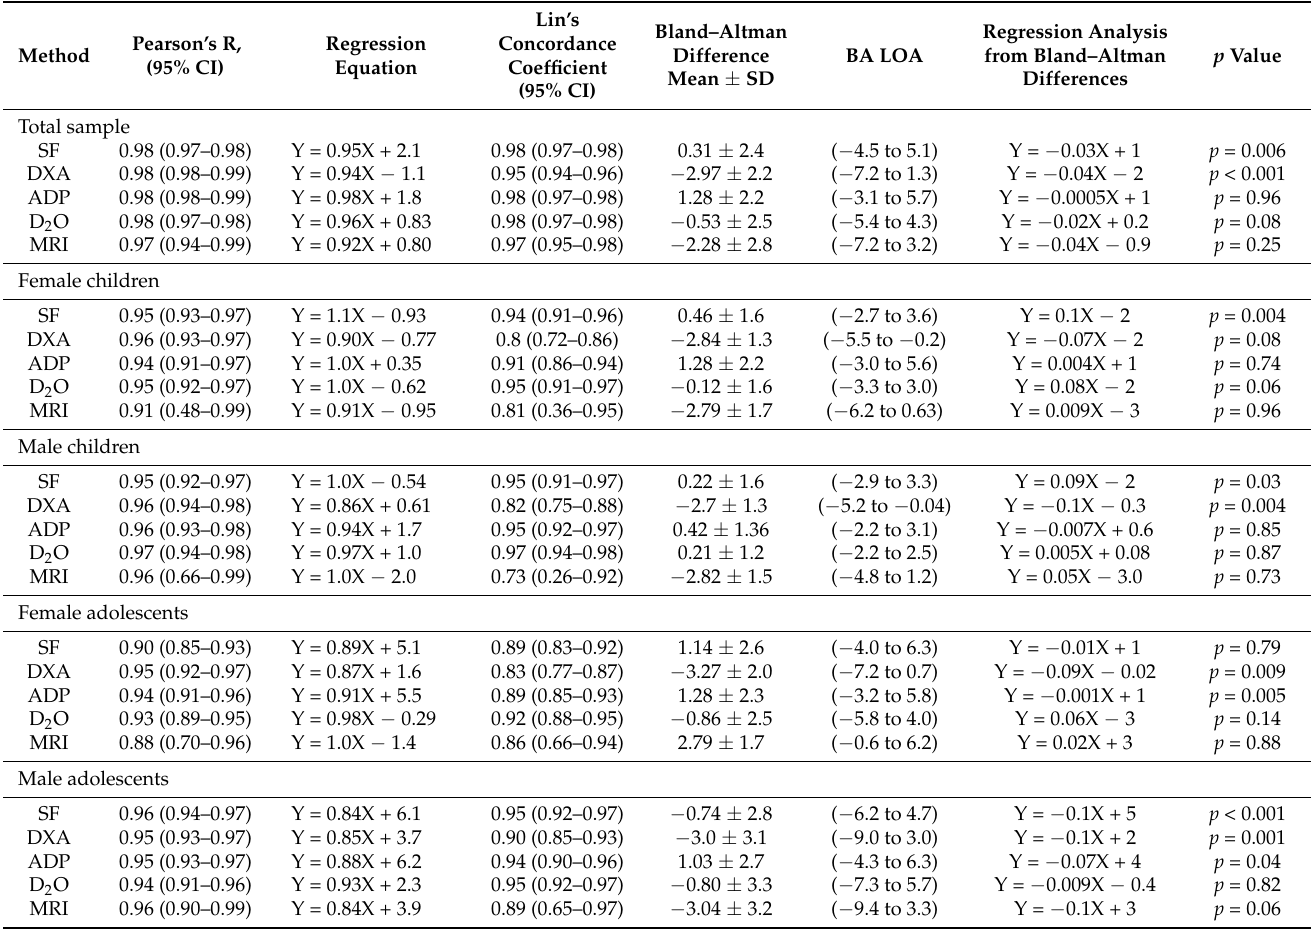
Table 3. Correlation, concordance, agreement, and proportional bias assessment between SF, DXA, ADP, D 2 O and MRI with respect to 4-C model for the estimation of fat free mass